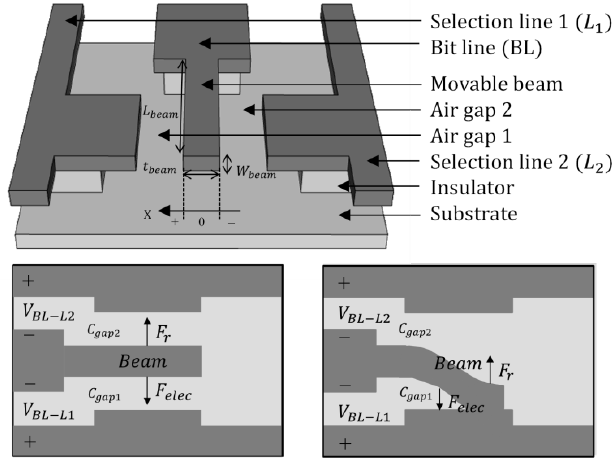
Figure 7. Design of nanoelectromechanical (NEM) memory switch [25].